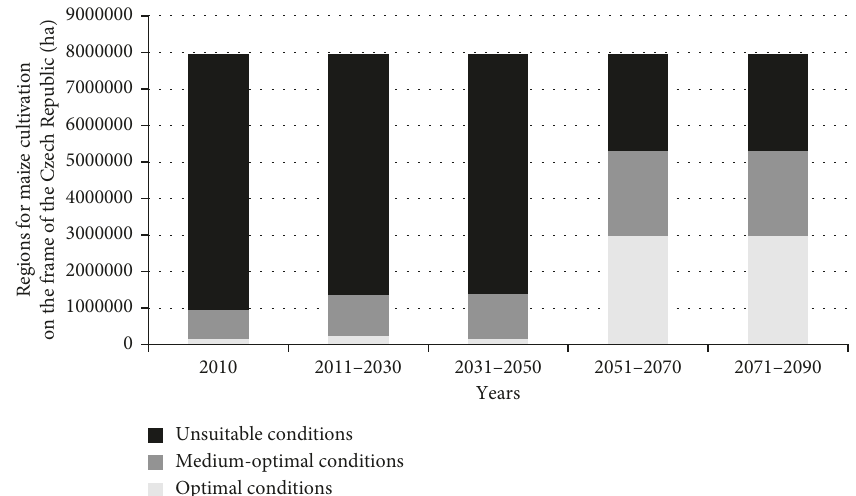
Figure 8: Scenario of changes in areas (hectares) with different climate conditions for grain maize growing in the study region of the Czech Republic based on the regional biogeographical model.